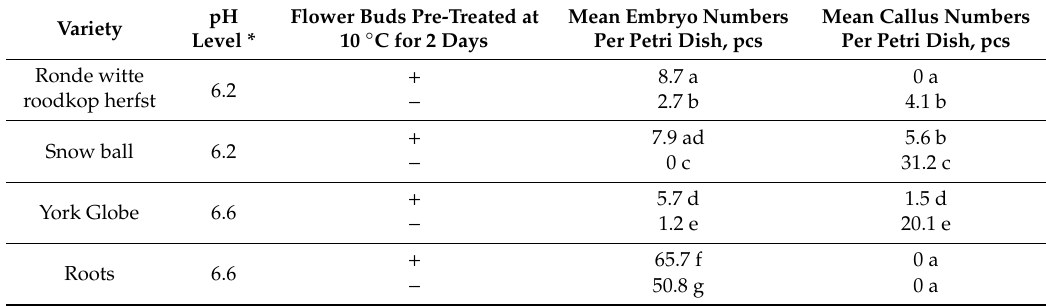
Table 3. Influence of flower bud cold pre-treatment on embryo development in turnip microspore culture.